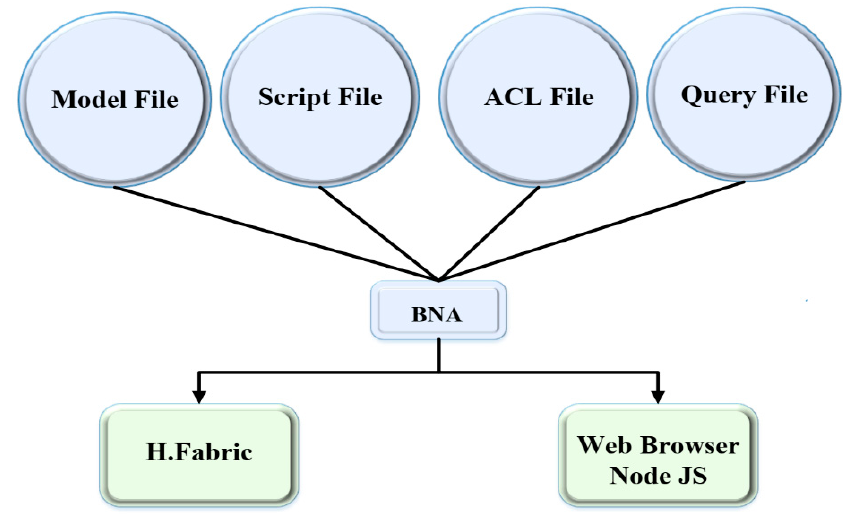
Figure 1. A global architecture for hyperledger composer.